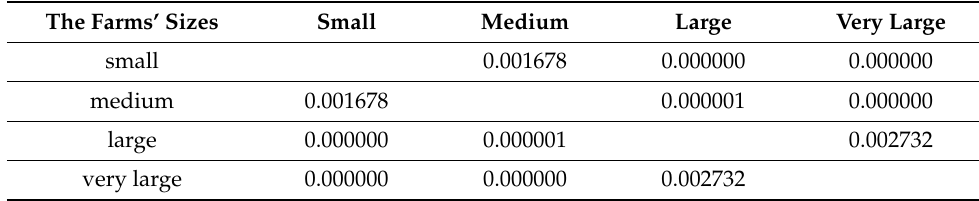
Table 4. Scheffe’s test (ANOVA).